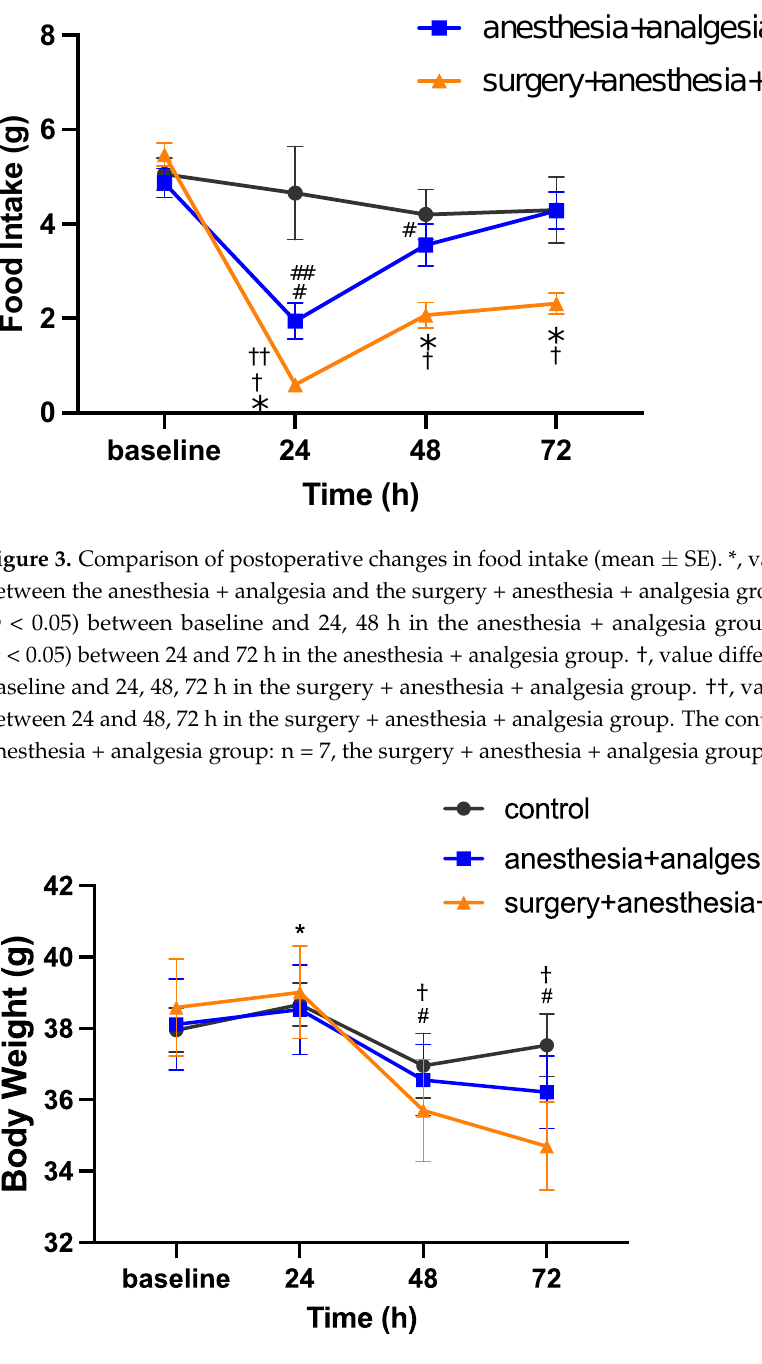
Figure 4. Comparison of postoperative changes in body weight (mean ± SE). *, value differs ( p < 0.01) between baseline and 24 h in the control group. #, value differs ( p < 0.05) between baseline, 24 h and 48, 72 h in the anesthesia + analgesia group. †, value differs ( p < 0.05) between baseline, 24 h and 48, 72 h in the surgery + anesthesia + analgesia group. The control group: n = 7, the anesthesia + analgesia group: n = 7, the surgery + anesthesia + analgesia group: n = 7.